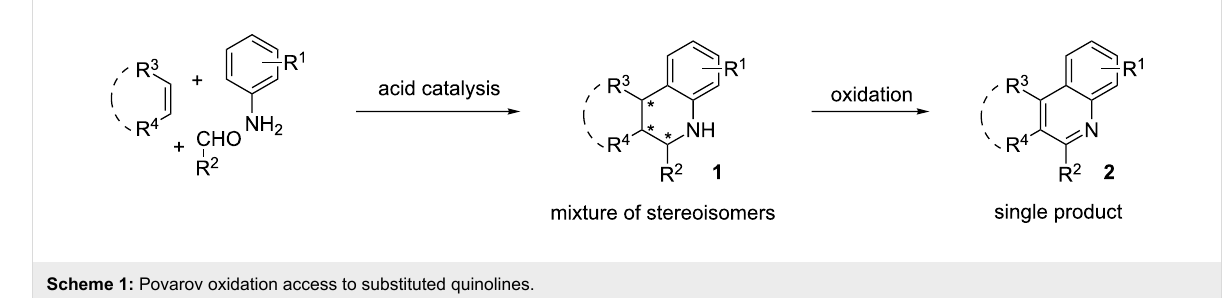
Scheme 1: Povarov oxidation access to substituted quinolines.